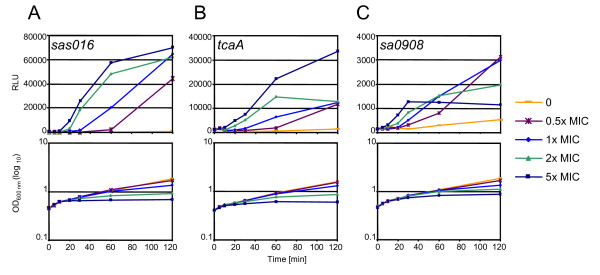
Induction kinetics of three CWSS promoters in response to varying concentrations of oxacillin. Luciferase activities and growth curves of strain BB255 containing: A, psas016-luc+; B, psa0908-luc+; and C, ptcaA-luc+; after addition of 0, 0.5, 1, 2 or 5-fold the MIC of oxacillin at time point zero.